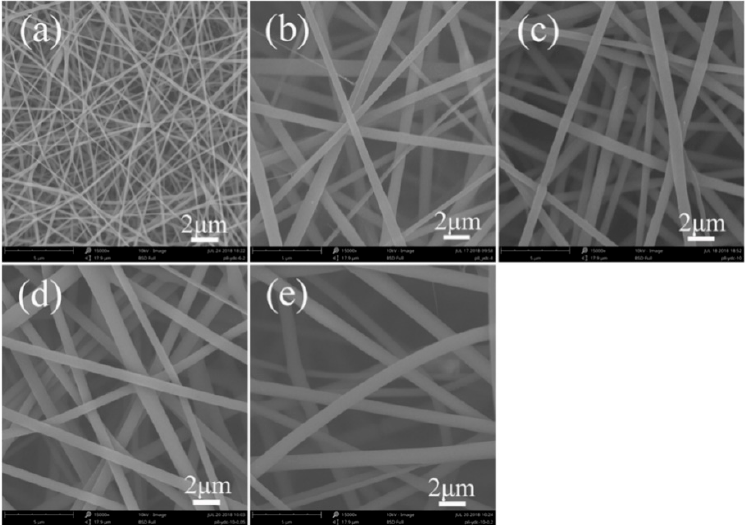
Figure 3. SEM images of fluorescent SF-AO nanofibers with different SF and AO concentration. The concentration of SF was ( a ) 6.0 wt%, ( b ) 8.0 wt%, ( c – e ) 10.0 wt%. The concentration of AO was ( a – c ) 1.0 wt%, ( d ) 0.5 wt%, and ( e ) 2.0 wt%, respectively.